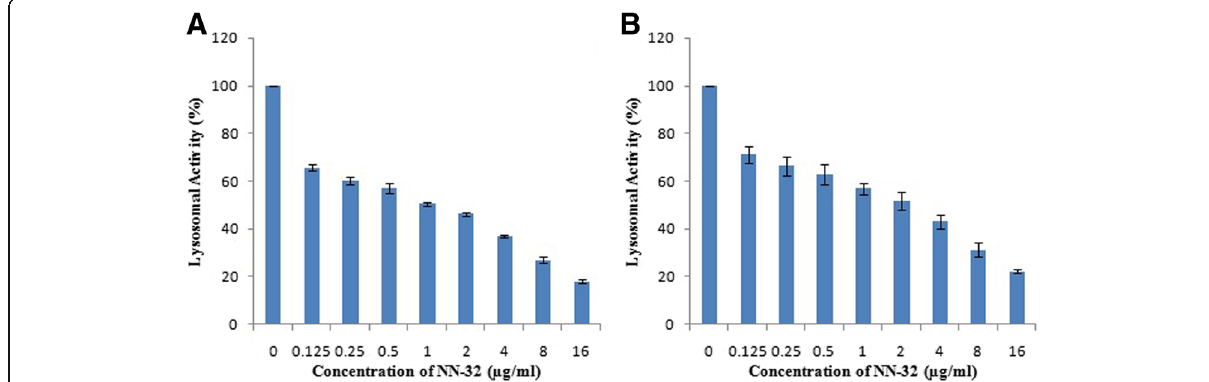
Fig. 7 Lysosomal activity of breast cancer cell lines treated with NN-32 toxin for 72 h, determined by neural red uptake assay. a MCF-7 cell line and, ( b ) MDA-MB-231 cell line. Values are expressed as mean ± Std. Dev ( n =